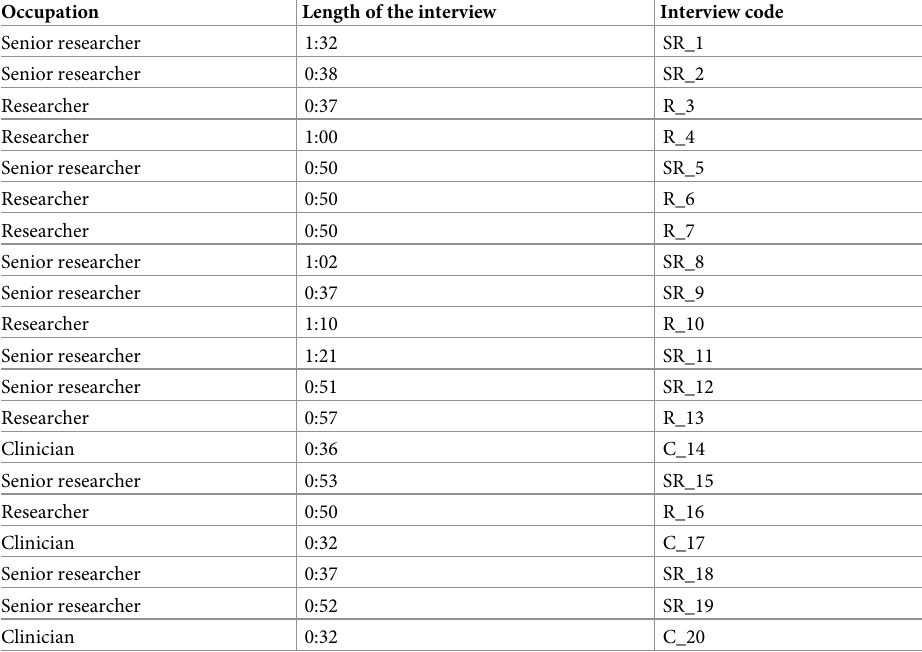
Table 2. Characteristics of researcher and clinician interviewees and